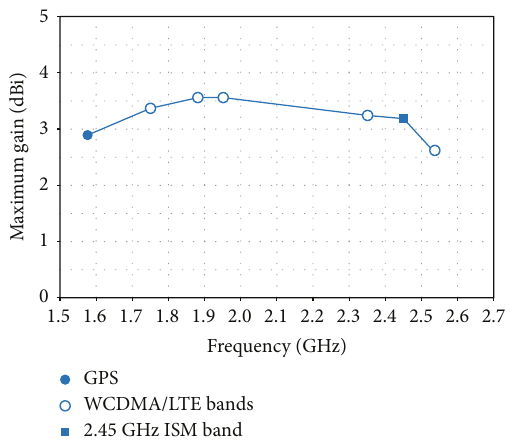
Figure 11: The maximum gain (dBi) of the non-foldable PCB